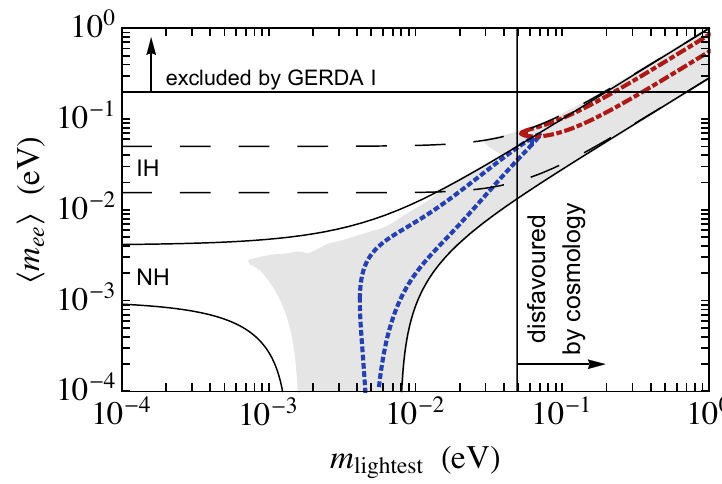
Figure 1 . The solid (dashed) lines bound the allowed region in the m lightest { h m ee i plane obtained by spanning the 3 (cid:27) ranges for the neutrino mixing parameters [9] in case of NH (IH). The dotted (dot-dashed) line is the prediction of eq. (2.10) on the e(cid:11)ective mass, once the NH (IH) best-(cid:12)t values of the neutrino mixing parameters are adopted [9]. The shaded region represents the 3 (cid:27) area obtained according to the neutrino mass-mixing dependent sum rule of eq. (2.10).